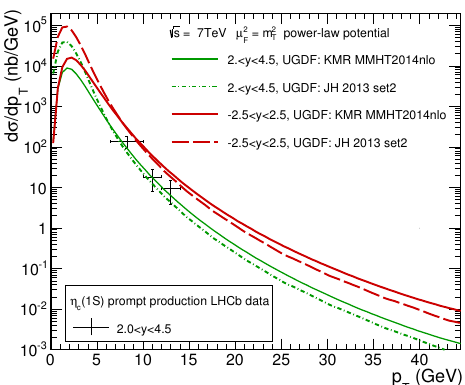
Figure 7 . Di(cid:11)erential cross section for prompt (cid:17) c (1S) production in a broad range of transverse